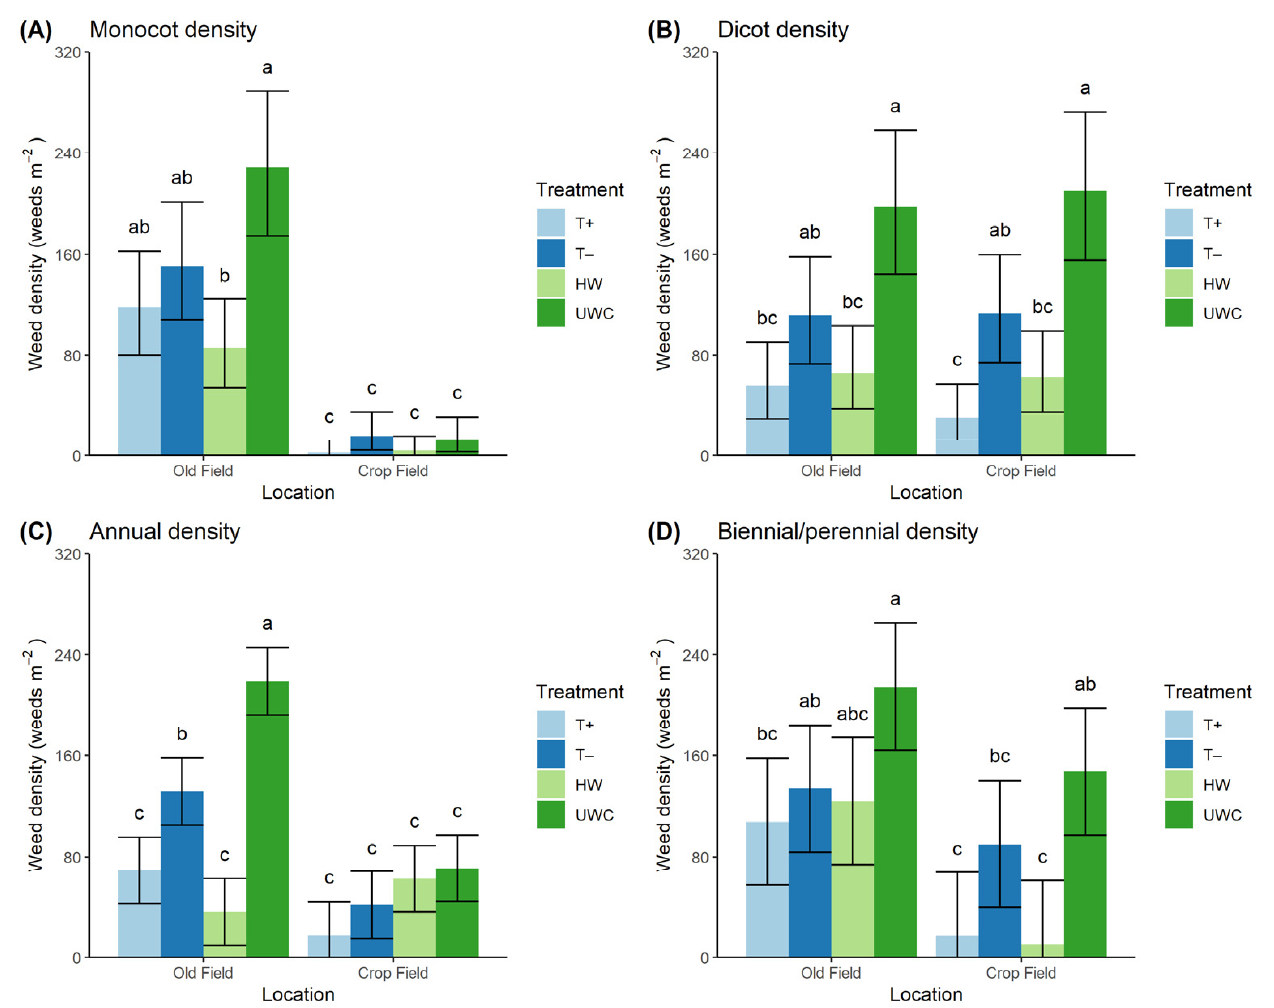
Figure 3. Effects of weeding treatment and location on weed density by ( A , B ) cotyledon type and ( C , D ) life cycle. Weed density was estimated by species on 20 August 2019; then these species-specific densities were aggregated by cotyledon type or life cycle. Bars marked with the same letter are not significantly different according to a Tukey test ( α = 0.05); 95% confidence intervals are shown. Abbreviations: T+—Tertill with trimmer; T − —Tertill without trimmer; HW—hand weeding by stirrup hoe; UWC—unweeded control.